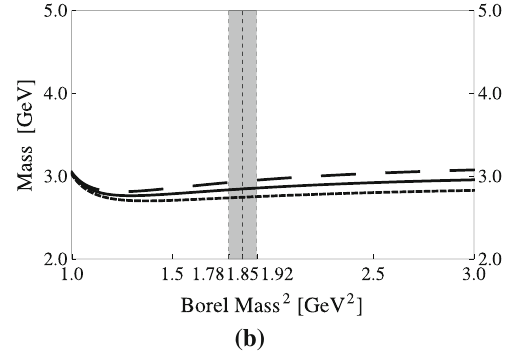
Fig. 7 The mass M (cid:2) extracted from the mixing current J 1 α 1 respect to a the threshold value s 0 and b the Borel mass M B : a the short-dashed/solid/long-dashed curves are obtained by setting M 2